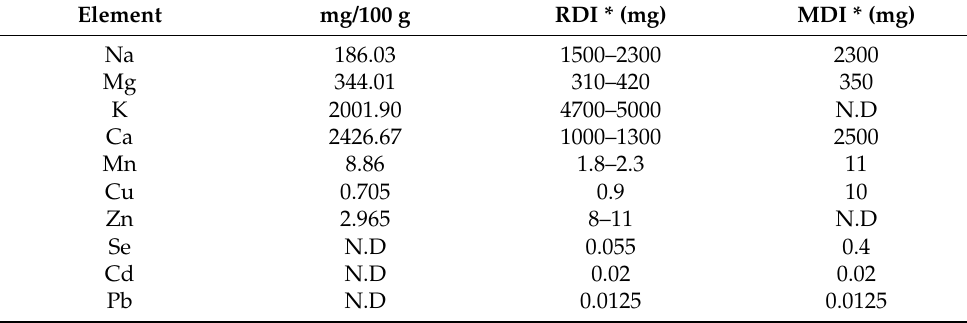
Table 2. Mineral contents (on a dry matter basis) of Colvillea racemosa leaves. Element mg/100 g RDI * (mg) MDI * (mg) Na 186.03 Mg